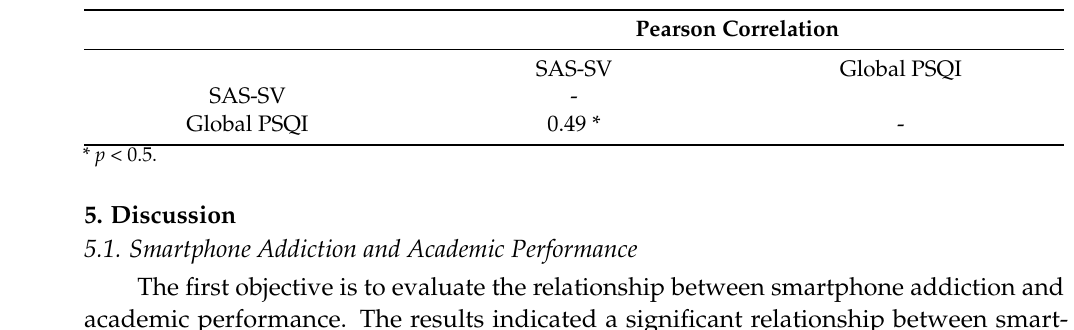
Table 12. Pearson correlation of smartphone addiction and sleep